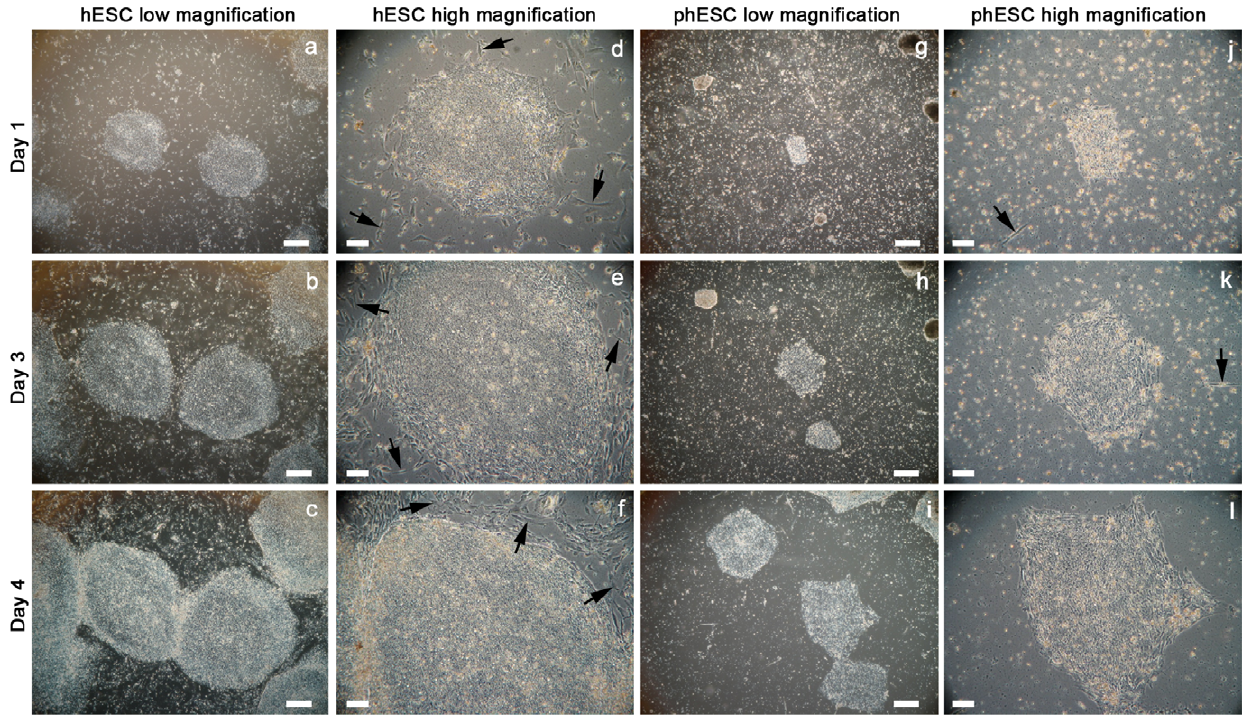
Figure 1. hESC and phESC differ morphologically. Conventionally-derived (a–f) and parthenote-derived (g–l) hESCs have distinct morphology and growth patterns in the undifferentiated state. High magnification and low magnification images have been provided for each colony to illustrate the slower growth of parthenote-derived colonies, irregular colony shape and lack of stromal cells (long, thin cells between colonies indicated by arrows) in the phESC cultures. Day 1 after plating (a, d, g and j). Day 2 after plating (b, e, h and k). Day 4 after plating (c, f, i and l). Scale bars represent 20 m m (a–c and g–i) and 10 m m (d–f and j–l). lines, indicating a low astrocyte presence within cultures. Cells showed no immunoreactivity in no-primary-antibody immunocy- tochemical control staining chambers.